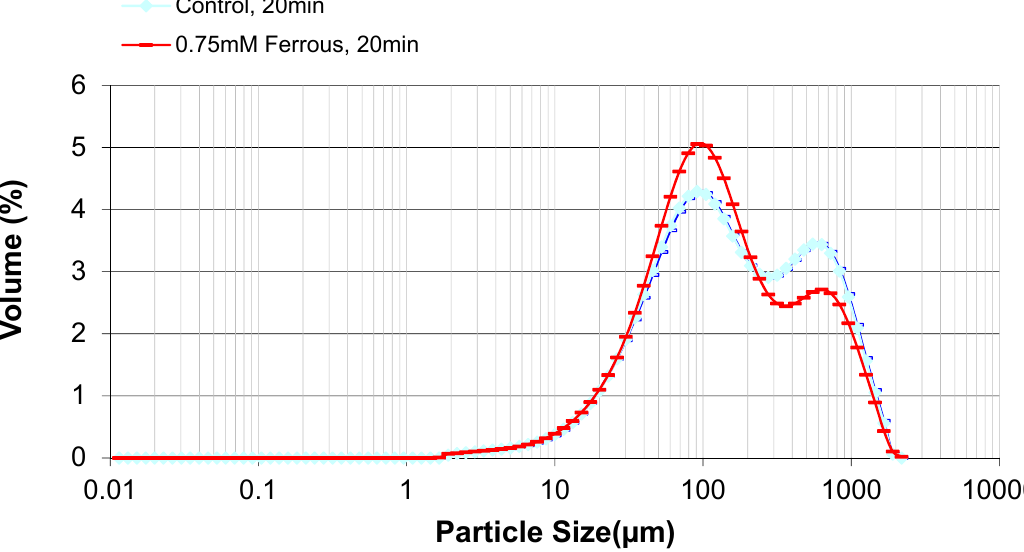
Figure 2. Particle size distribution with and without the ferrous sulfate addition.